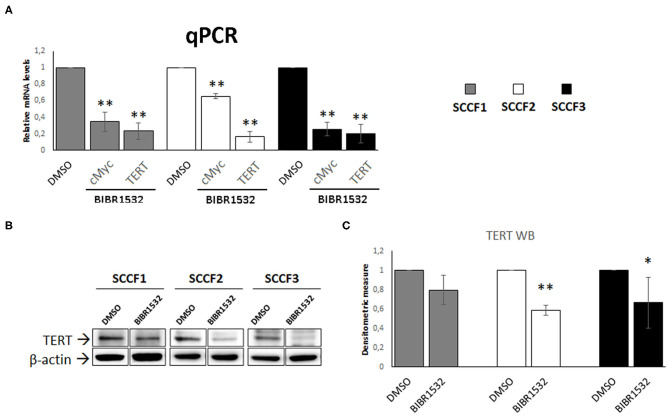
BIBR1532 down-regulates cMyc and TERT in FOSCC cell lines. (A) SCCF1, SCCF2, and SCCF3 were treated with BIBR1532 at 50 μM vs DMSO and analyzed by qPCR for TERT and cMyc gene expression. Data were normalized for β2-microglobulin as housekeeping gene and expressed as relative quantization by the 2−ΔΔCt method. Changes in relative mRNA levels were calculated for SCCF1, SCCF2, and SCCF3 treated with BIBR1532 compared with their respective DMSO control set as 1. Plots represent the mean ± standard deviations (SD) of at least three repeated, independent experiments performed in technical triplicate. (B) A representative Western blotting (WB) gel for TERT protein expression in BIBR1532- vs. DMSO-treated cells. The blot was stripped and reprobed for β-actin to ensure comparable protein loading and allow normalization. For each cell line, boxes are cut from the same gel at the same exposure time and properly aligned according to molecular standards loaded onto the gel. Full scans from original gels are shown in Supplementary Figure 3. (C) Mean densitometric values normalized for β-actin expression ± SD from at least three repeated, independent WB experiments. Changes in protein levels were calculated for SCCF1, SCCF2, and SCCF3 treated with BIBR1532 compared with their respective DMSO control set as 1 (statistically significant, *P < 0.05 and **P < 0.01).